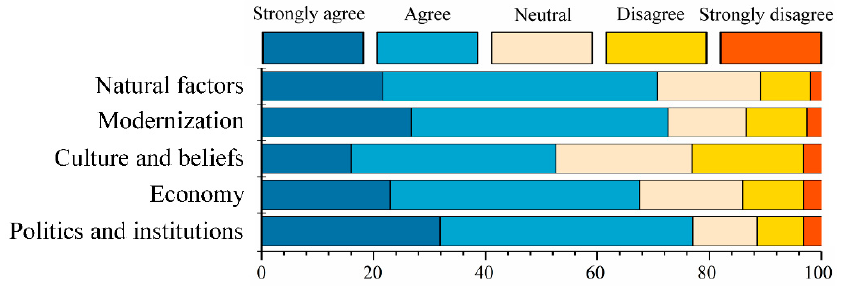
Figure 14. Proximate drivers of landscape change in the Nzhelele and Levuvhu river catchments.